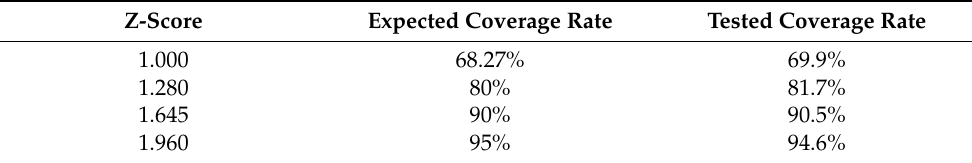
Figure 9. Actual load and 95% prediction intervals of a summer week (beginning from 8.8) and a winter week (beginning from 1.9) for 2014 for the ISO-NE dataset. Table 8. Tested coverages of the proposed model with MC